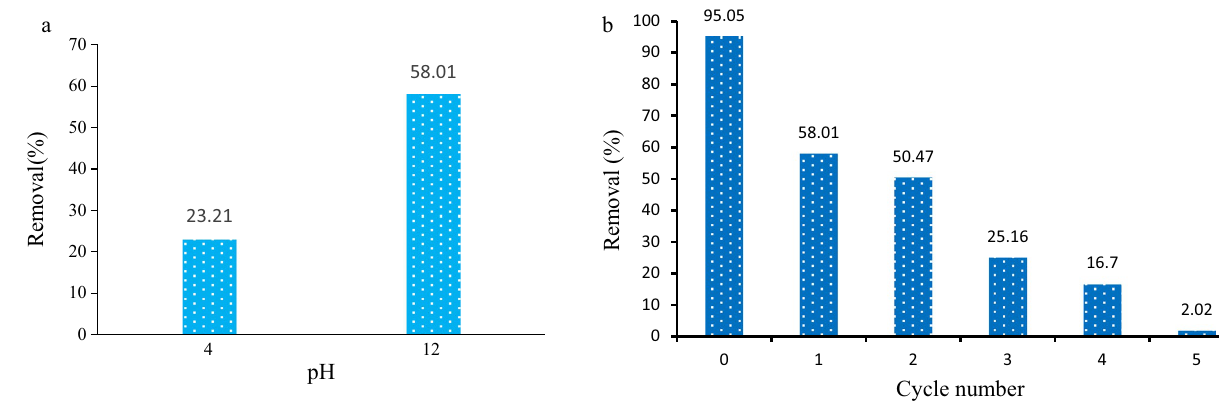
Fig. 7 γ -Al 2 O 3 NPs reusability; RR-141 removal efficiency for NPs regenerated by alkaline/acid eluting solution ( a ) and RR-141 removal in con- secutive adsorption/desorption cycles ( b